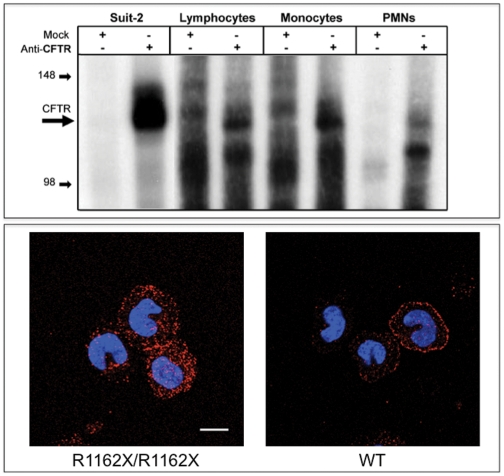
Expression of CFTR in leukocytes.
Upper Panel: Membrane localization of CFTR in leukocytes. CFTR was immune-purified from 200 µg of light membrane samples of non-CF lymphocytes, monocytes and neutrophils using a mixture of two anti-CFTR antibodies (ACL-006 and MM13-4) and subjected to PKA-dependent in vitro phosphorylation. CFTR was detected as a specific band at approximately 140 kDa. The Suit-2 pancreatic adenocarcinoma cell line was used as a positive control. The band was not detectable when immune precipitation was performed with isotypic antibodies (Mock). Lower Panel: Confocal microscopy analysis performed using the 13-1 antibody on monocytes derived from subjects carrying a truncated (R1162X/R1162X) and wild type forms of CFTR. Membrane localization is detected in WT monocytes while R1162X/R1162X ones display a disorganized distribution of the signal. The bar indicates 10 µM (one experiment of 3 performed).